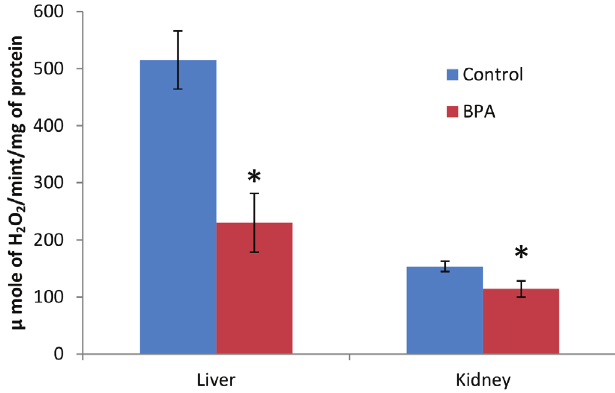
FIGURE 3 - Catalase activity in the liver and kidneys of C.idella (n=5), exposed to the sublethal concentration of BPA for 14 days. The values given are mean ± S.E.M. * = p<0.05.